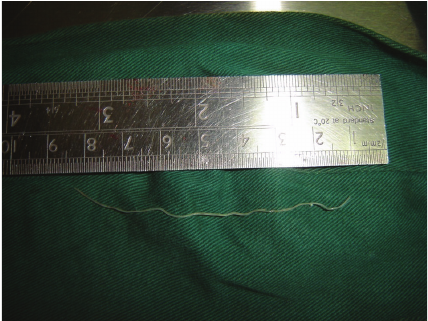
Figure 2: Specimen of Dirofilaria repens .